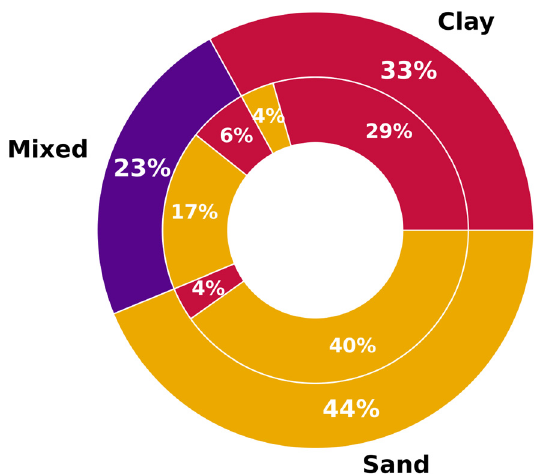
Figure 2. Distribution of the predominant soil type (outer level), and the bearing soil layer per each soil type (inner